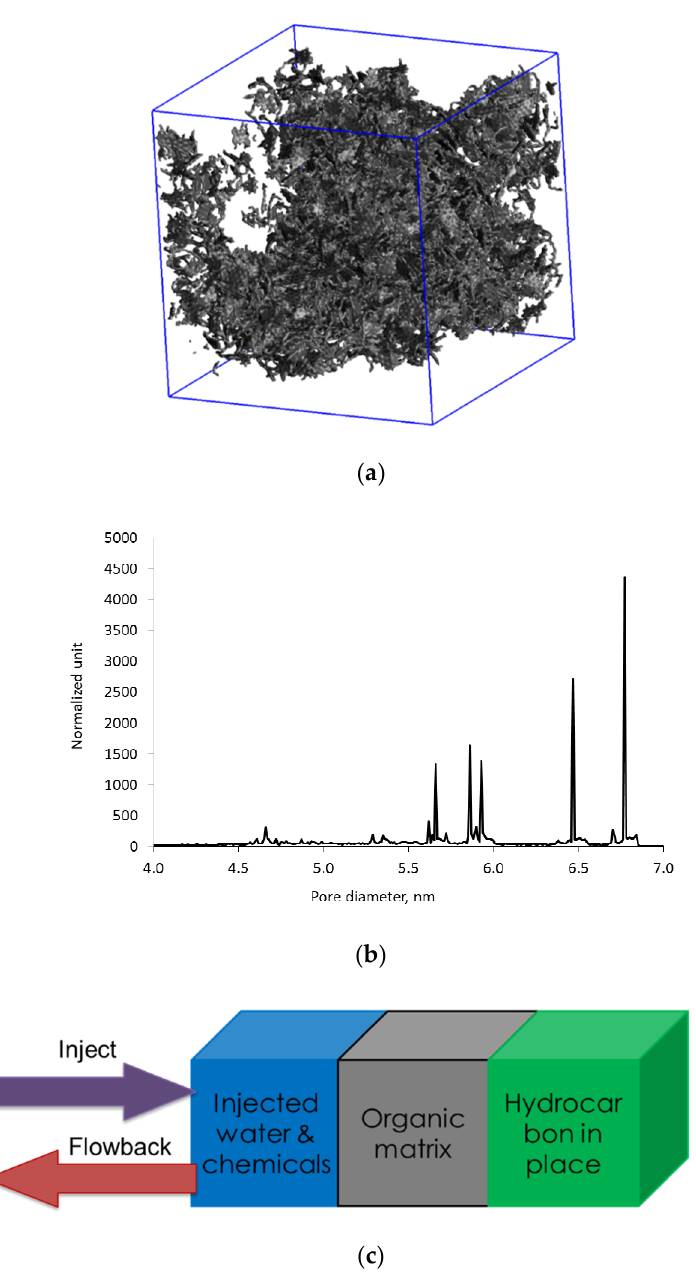
Figure 7. ( a ) The three-dimensional (3D) atomistic model of kerogen saturated with oil at reservoir conditions corresponding to 150 bar and 80 °C; ( b ) Pore size distribution of the kerogen model indicating pore size range between 4 and 7 nm; ( c ) Diagram showing the setup of MD simulations to mimic the injection and flowback stage of oil production from a 3D kerogen network.